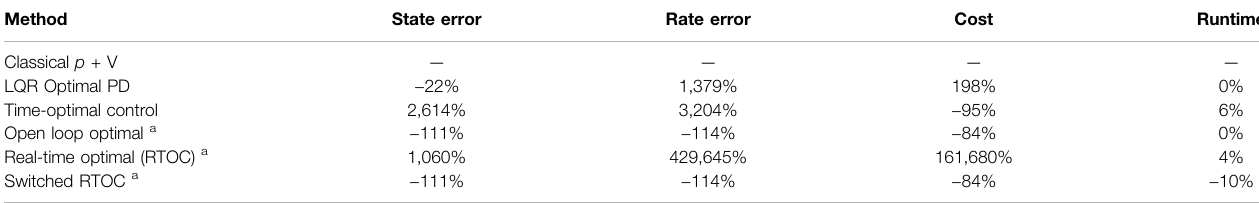
TABLE 8 | Percentage change in performance in one-thousand-run (respectively) Monte Carlo analysis: double-integrator plant ( with transport theorem) with control design based off double-integrator with transport theorem and noisy, mixed sensors (state and rate).